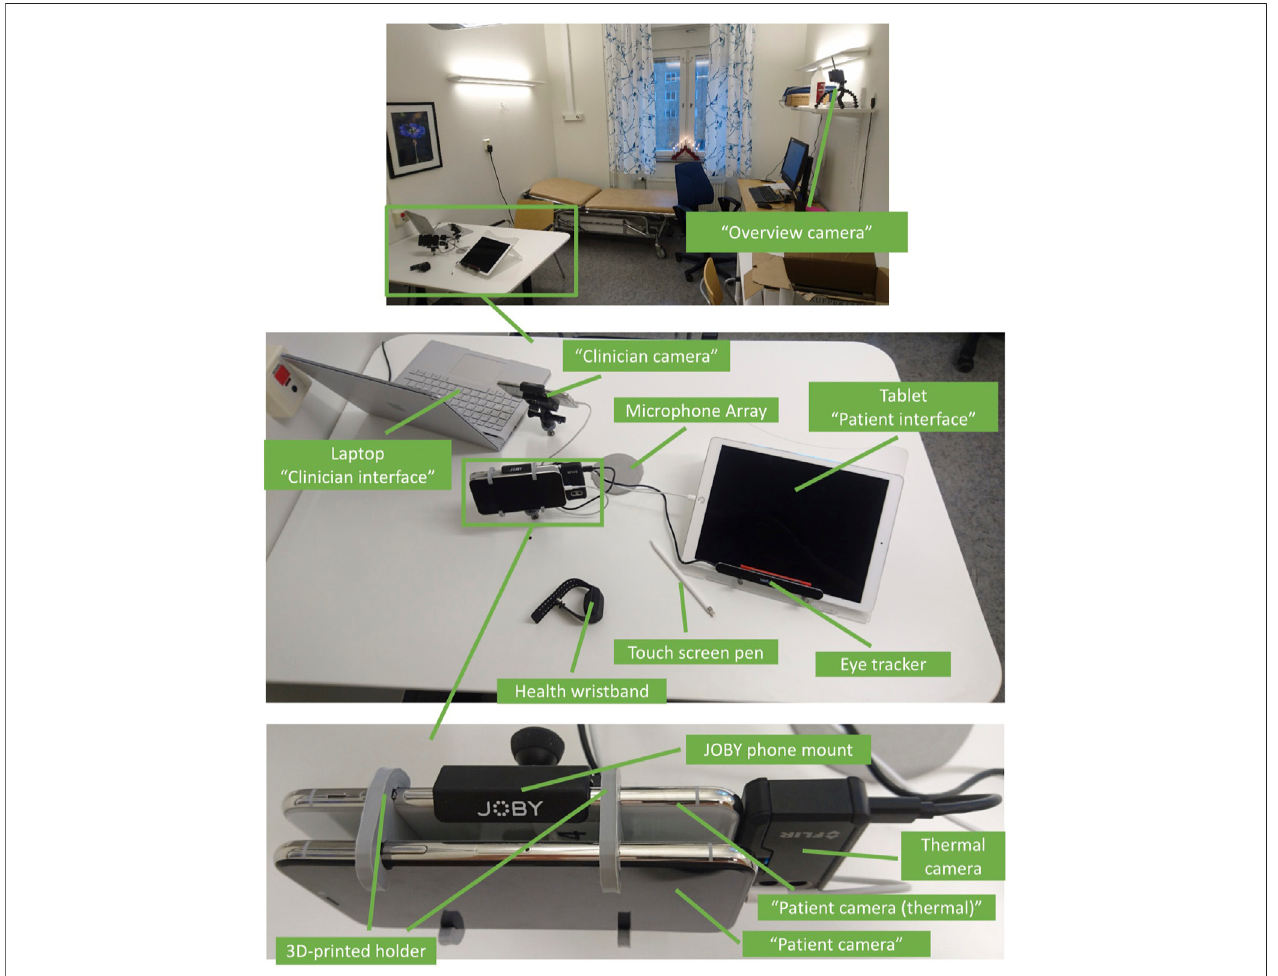
FIGURE1| Thedatacollectionsetup.Atthetop anoverviewoftheroom isgiven, showingboth theinstrumentedrecordingtableand thepositionofthe “ overview camera ” . In the middle the various devices on the instrumented recording table are shown and at the bottom a close-up of the patient facing cameras.